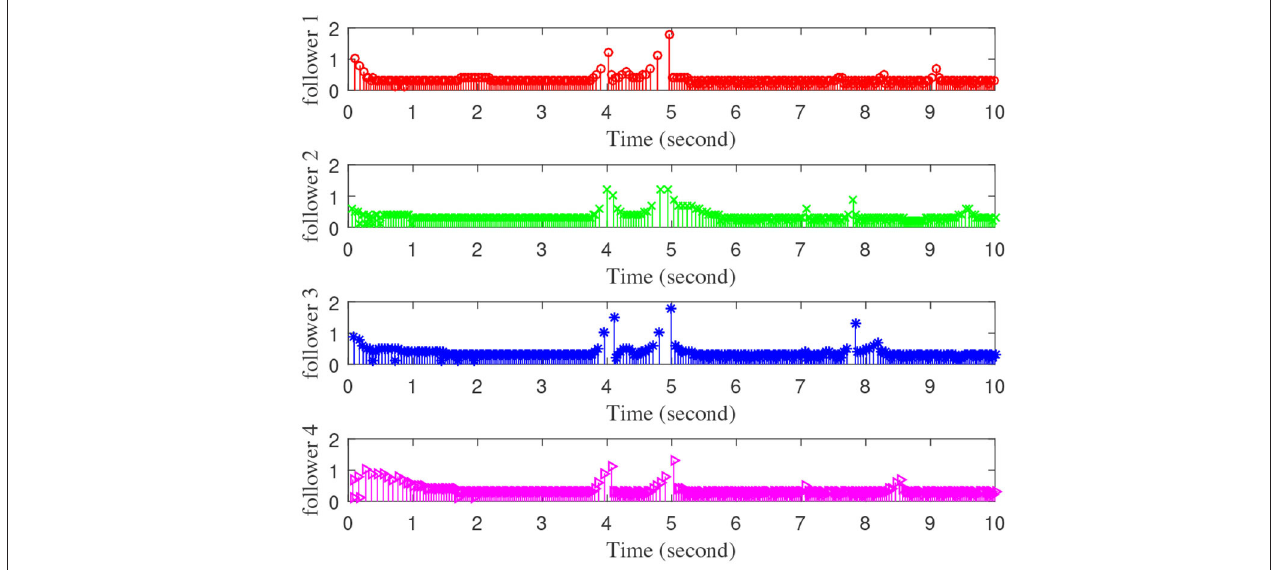
FIGURE 11 | The event trigger interval of each follower vehicle.